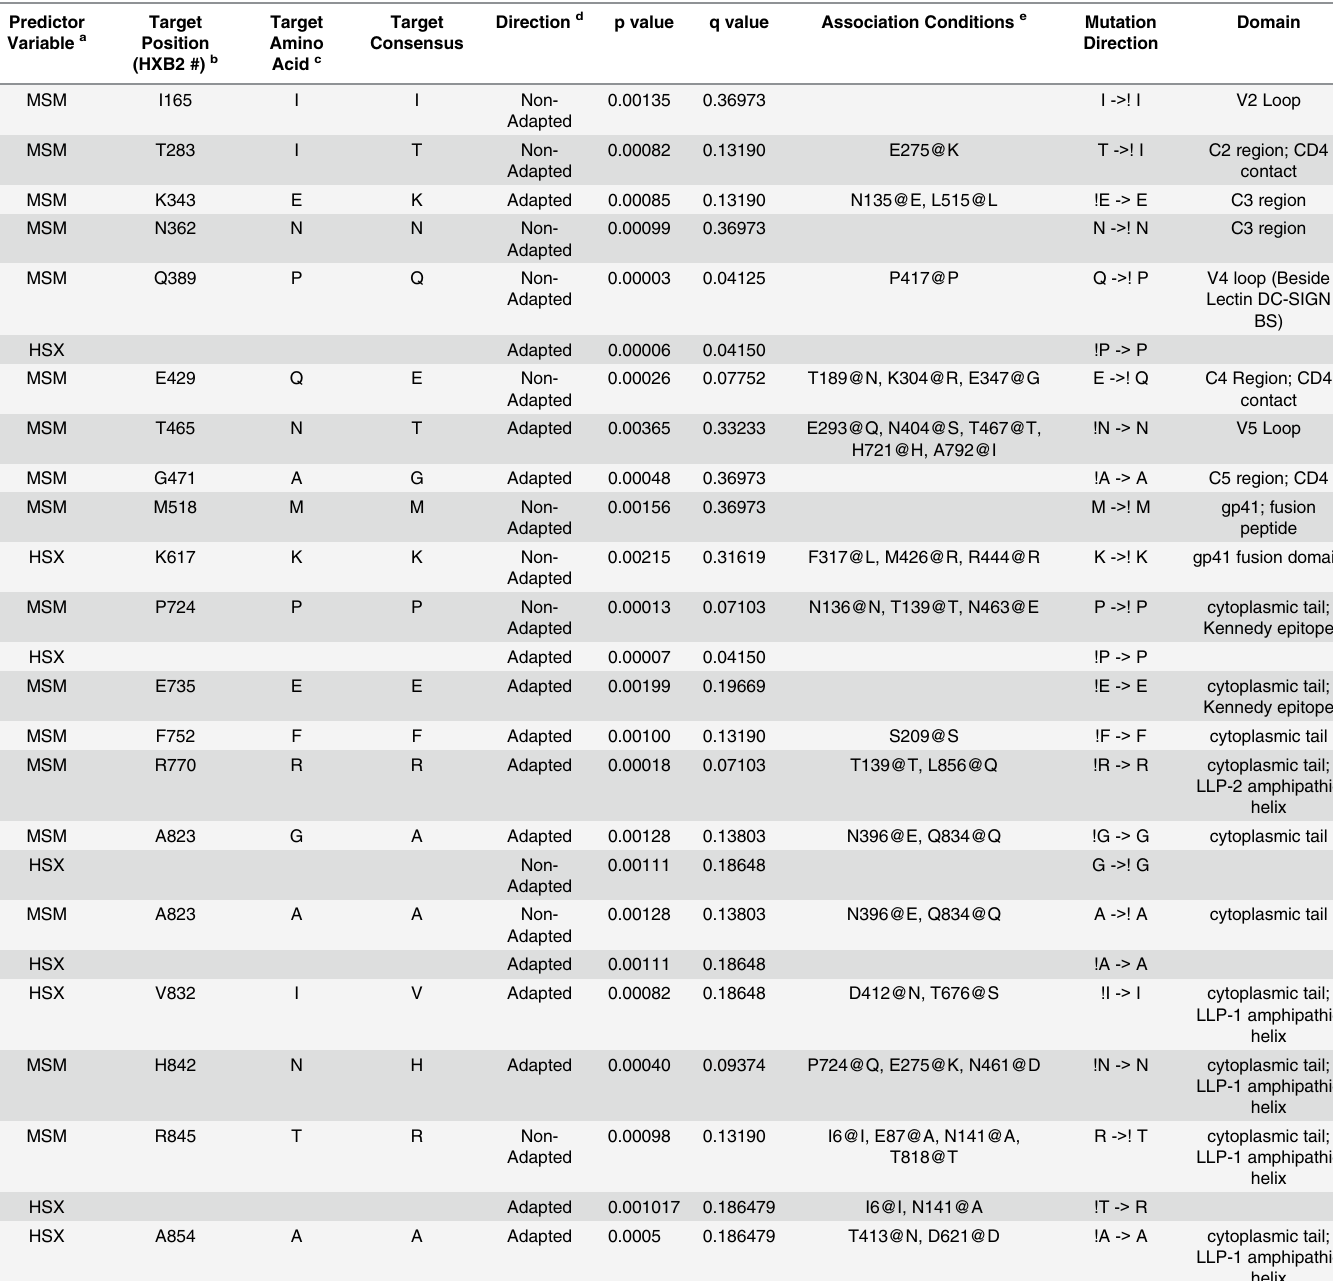
Table 3. Signature sites identified between MSM and HSX Founder viruses in Env using a phylogenetic corrected method. Predictor Variable